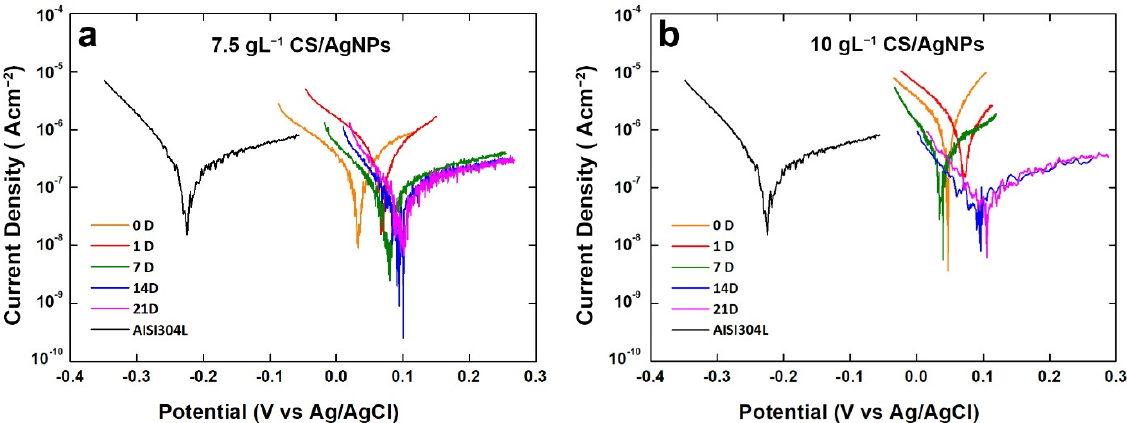
Figure 6. Polarization curves of the composite coatings obtained using different concentrations of CS after different aging times. Table 1. Corrosion potential (E corr ) and corrosion current density (i corr ) extrapolated by Tafel curve for the coatings after different aging time in